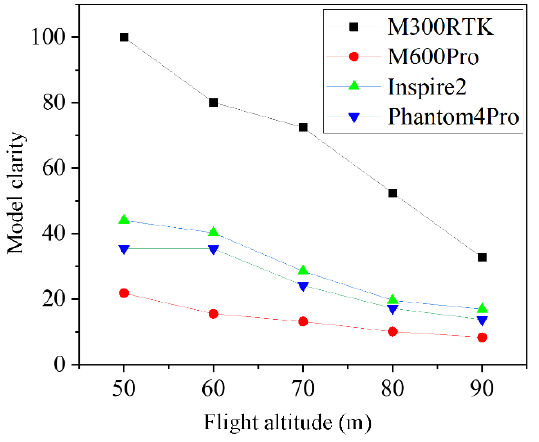
Figure 7. Clarity comparison of different 3D reconstruction models using the same equipment.